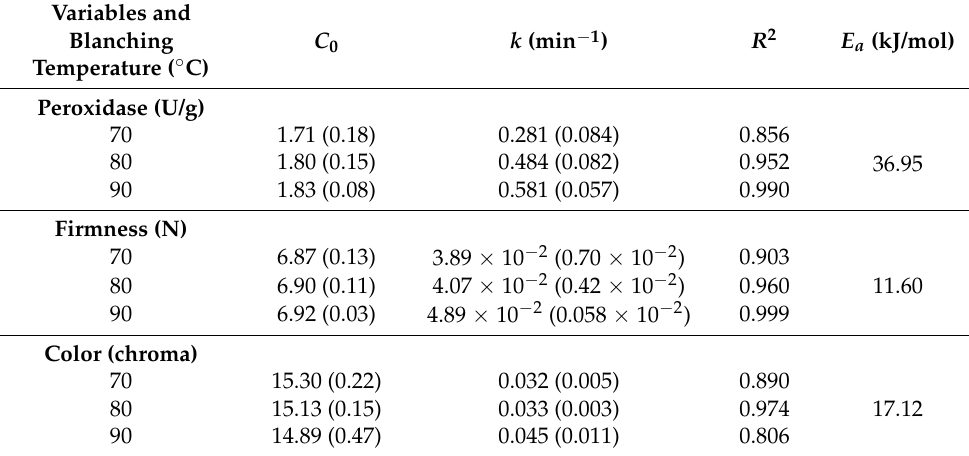
Table 1. First order kinetic parameters for estimating peroxidase denaturation (U/g), firmness property (N), and color change (chroma index) of fresh cowpeas submitted to blanching at differ- ent temperatures.